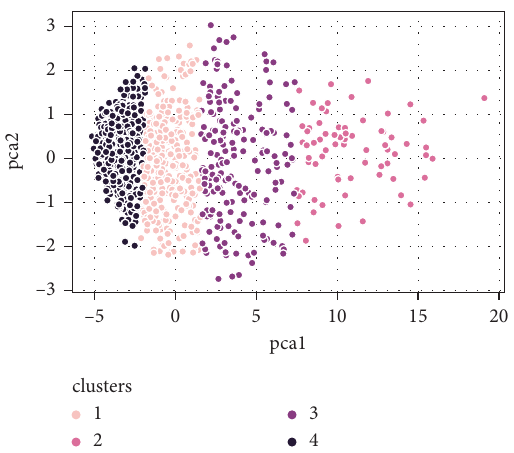
Figure 3: K-means clustering for Scenario